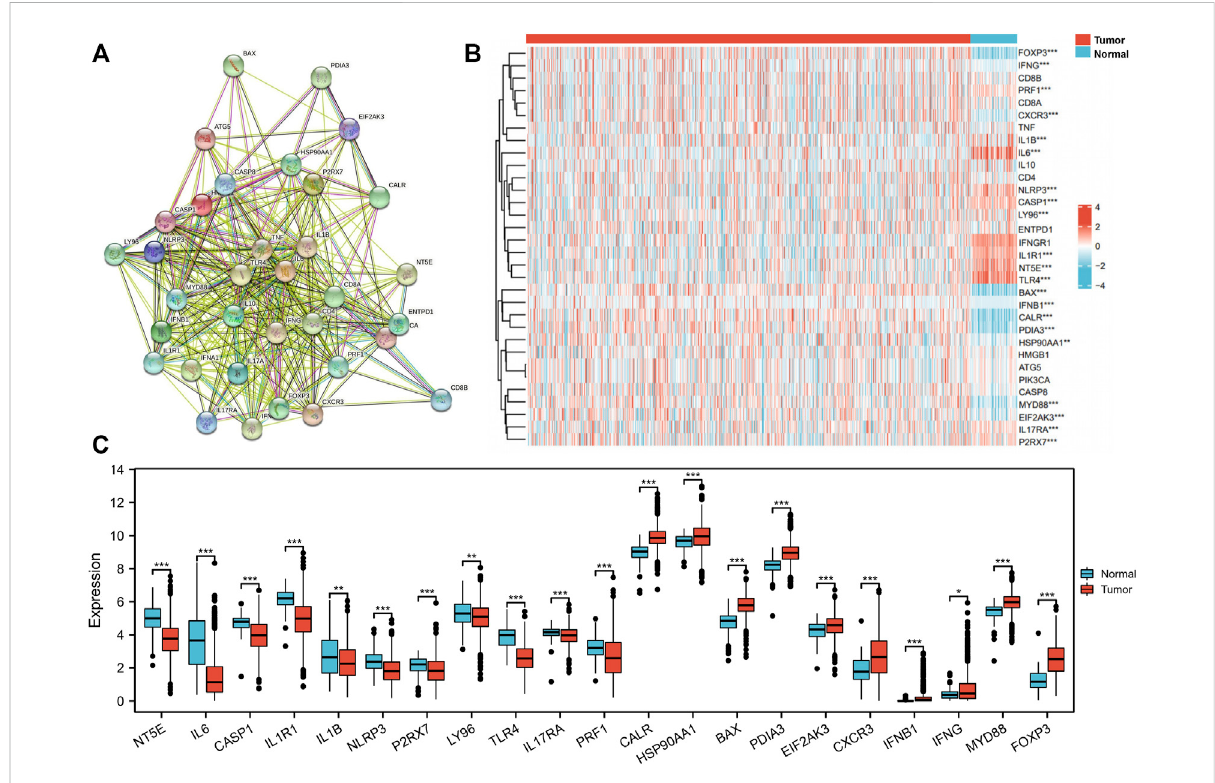
FIGURE 4 Identi fi cation of immunogenic cell death (ICD)-related gene expression pattern in The Cancer Genome Atlas (TCGA) breast invasive cancer (BRCA) cohort. (A) Protein – protein interactions among the 34 ICD-associated genes (number of nodes: 34, number of edges: 332, average node degree: 19.5, average local clustering coef fi cient: 0.8, expected number of edges: 62, and PPI enrichment p -value: < 1.0e-16). (B) Heatmap of 32 ICD-related gene expression between tumor and normal tissue in the TCGA BRCA cohort. (C) In total, 21 genes with different expression patterns between tumor and normal tissues in the TCGA BRCA cohort. * p < 0.05, ** p < 0.01, *** p <